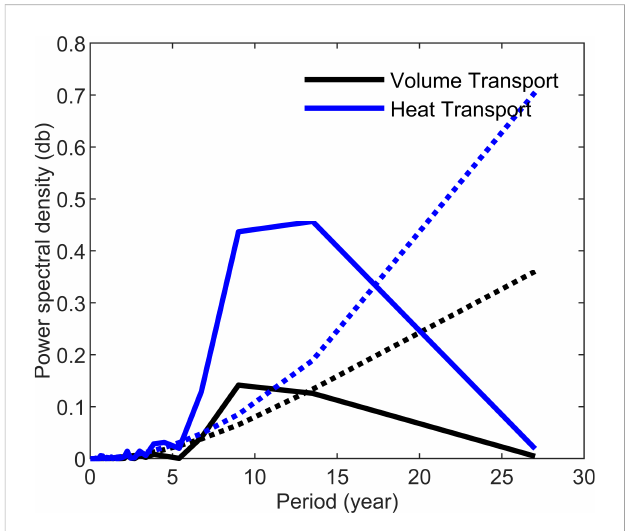
FIGURE 8 Power spectrum of the seasonal amplitude time series of volume and heat transports. The black solid line represents the result of volume transport, and the black dotted line represents its 95% con fi dence level; the blue solid line represents the result of heat transport, and the blue dotted line represents its 95% con fi dence